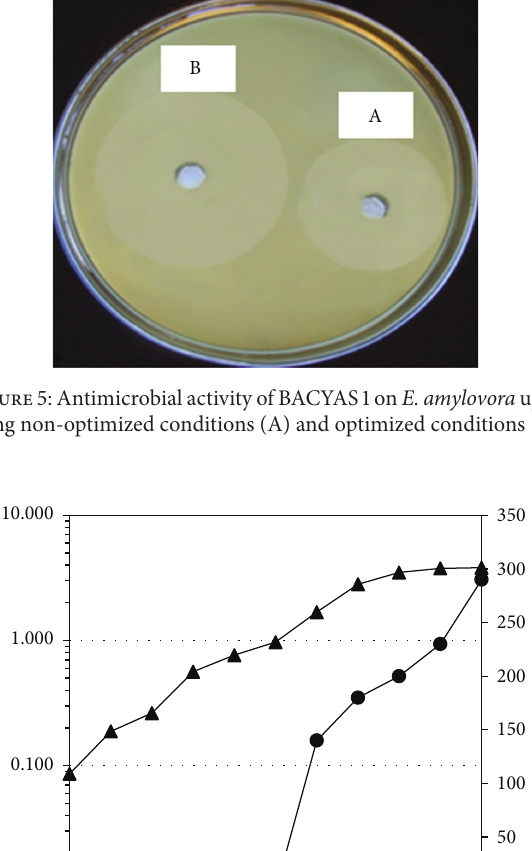
Table 5: Effect of temperature on BAC YAS 1 antimicrobial